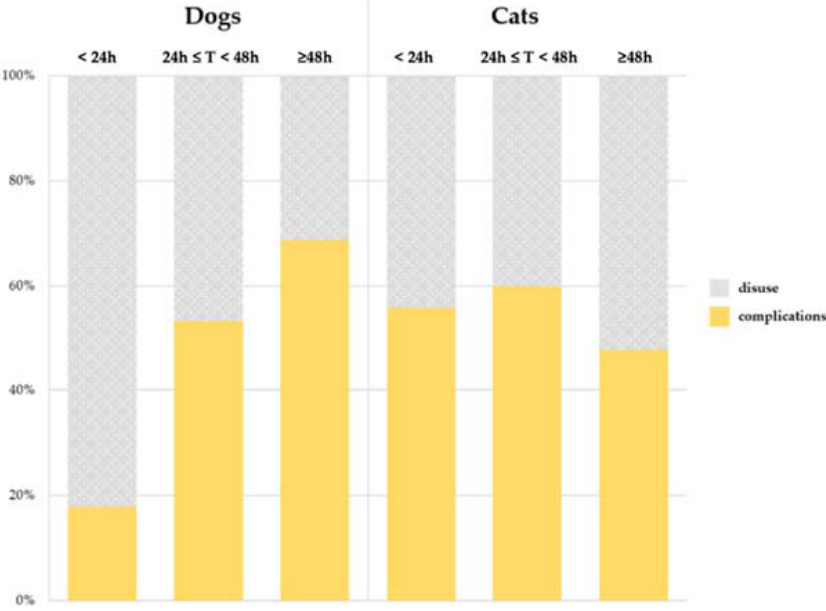
Figure 4. Causes of catheter removal according to the permanence time of the device.